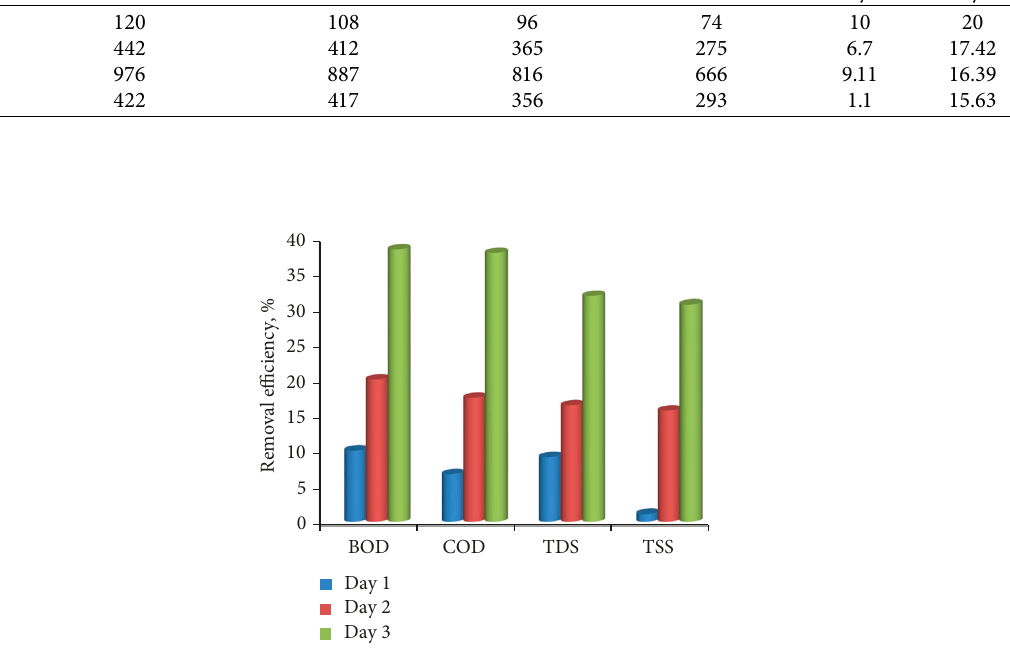
Figure 5: Graphical representation of BOD, COD TDS, and TSS removal using Areca husk with varying the time periods.